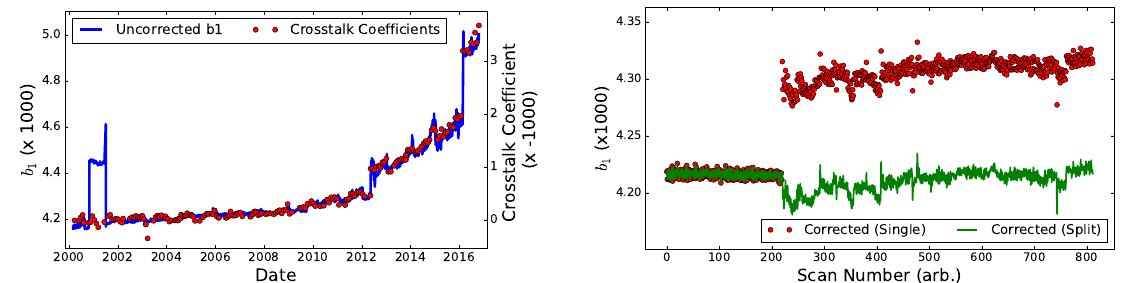
Figure 7. Example of the change in the value of b 1 for band 29, detector 10 in Terra MODIS over the whole mission ( left ) and over a short time period on 11 May 2012 ( right ). In the left figure, we also plot a scaled version of the crosstalk coefficients (right axis) over the values of b 1 . Early in the mission ( ∼ 2001), the change in b 1 is related to the change the electronics side from side-A to side-B and then back, and is unrelated to the crosstalk issue. In the right figure, we show the crosstalk correction on the scan-by-scan b 1 using a single set of correction coefficients (red), and using the correction coefficients derived from surrounding lunar events, split about the scan where there is a jump in the value of b 1